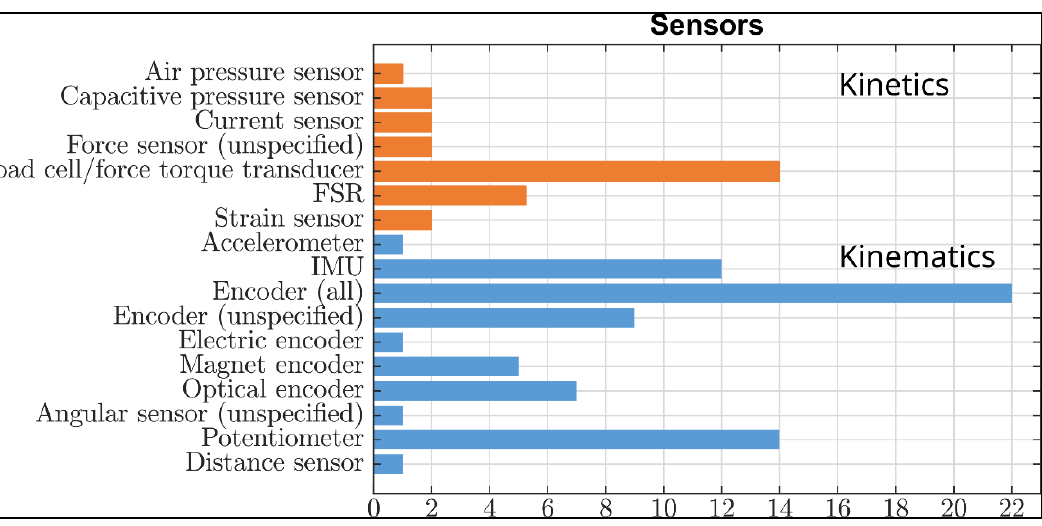
Figure 4. Sensors used in studies (please note that in some studies, multiple sensors were used). Most of the studies (n = 27) used the exoskeleton as an assessment tool within a broader (intervention) study. The respective test procedure was validated in 19 studies, and tested for reliability in six studies, with three studies performing both validity and reliability testing. Two studies [51,82] only presented results from an experiment without any participants. In four studies [52,67,78,81], the number, health status, age, and sex of participants were not mentioned. The remaining 43 studies included a total of 631 participants. Of these, 48.3% (n = 305) were male, 34.1% (n = 215) were female, and Table 3. Results of the quality assessment of validity and reliability studies. The reader is referred sex/gender was not specified for the remaining 17.5% (n = 111) participants. More than half to National Heart, Lung and Blood Institute (2021) [35] for further details on the different items of of all participants (58.9%; n = 372) were described as healthy, able-bodied, or unimpaired. the quality assessment tool (na, not applicable). 13.5% (n = 85) of participants had an incomplete spinal injury, and 10.1% (n = 64)